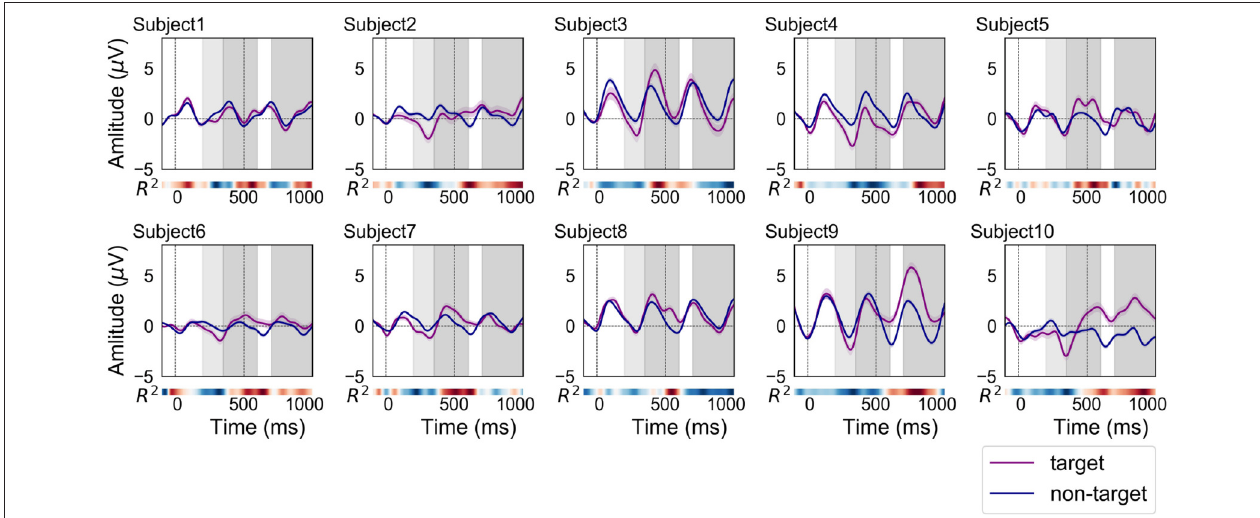
FIGURE 5 | ERP and non-ERP waveforms of each subject in the online analysis 2 (purple line: ERP, blue line: non-ERP). The filled fields along the plots denote the standard error (SE) of amplitudes for each time point. The time interval for N200 is filled with light-gray color at 200—350 ms. In addition, the time intervals between 350–600 and 700–1,000 ms were filled with dark-gray color for finding the positive peaks of ERP